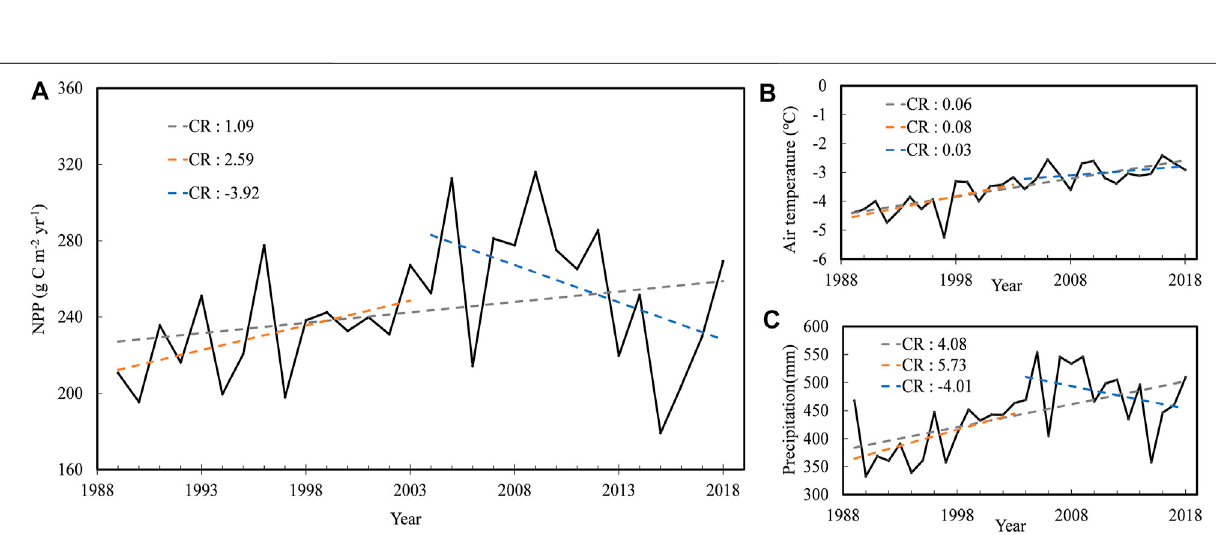
FIGURE 5 | Distribution of net primary product (NPP) (A) averaged over the 1989 – 2018 period in the TRHR, along with spatial distributions of mean annual air temperature (B) and mean annual precipitation (C) over the same period. Lakes are excluded in (A) .